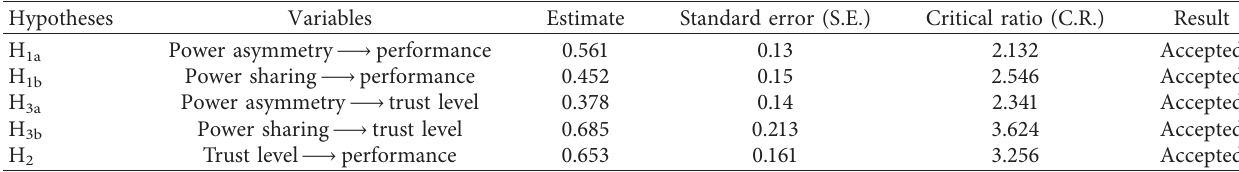
Table 3: Results of the structural equation